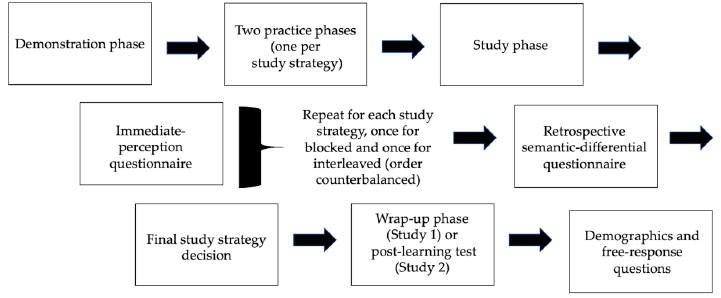
Figure 2. Flow of study activities in Study 1 and Study 2.